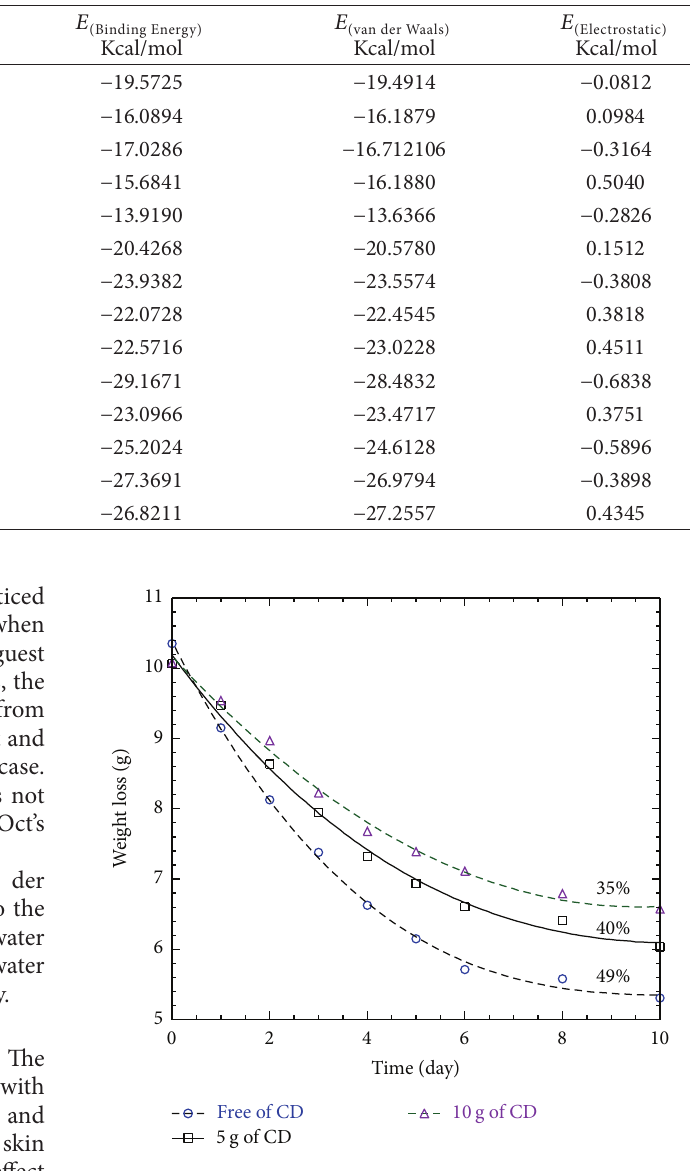
Figure 10: Loss in mass of sunscreen lotion along ten days with different amounts of 𝛽 -CD: Free of 𝛽 -CD, 5g of 𝛽 -CD, and 10g of 𝛽